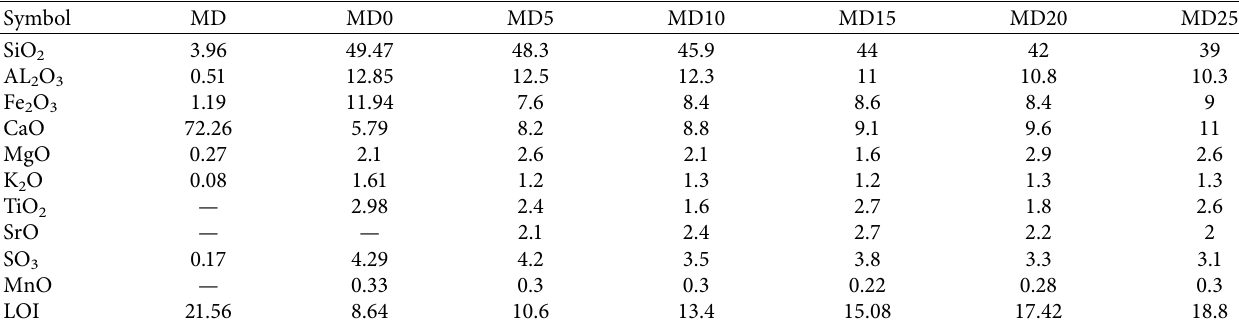
Table 3: Chemical composition of MD, raw soil, and raw soil-MD mixes, as determined from XRF. Symbol